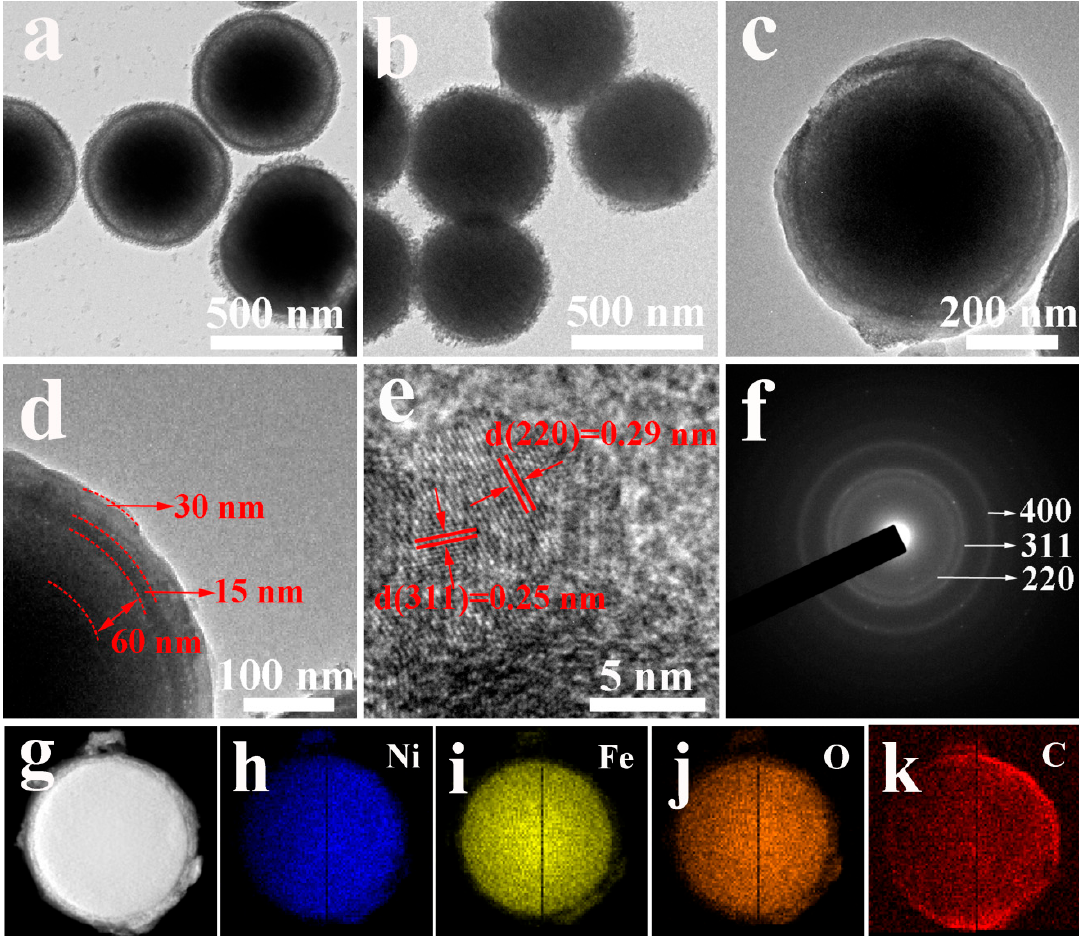
Figure 2. FESEM images of ( a , d ) NFO-YS, ( b , e ) NFO-S, and ( c , f ) NFO-YS@C.